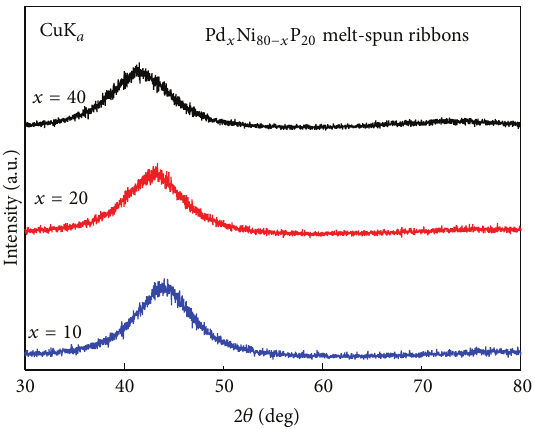
Figure 1: XRD patterns of the Pd 𝑥 Ni 80−𝑥 P 20 (𝑥 = 10, 20, 40) ribbon samples.